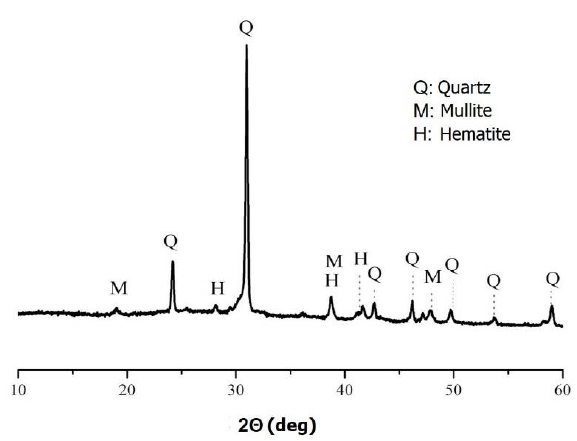
ff raction (XRD) of the Figure 2. X-ray diffraction (XRD) of the FA. Figure 2. X-ray di